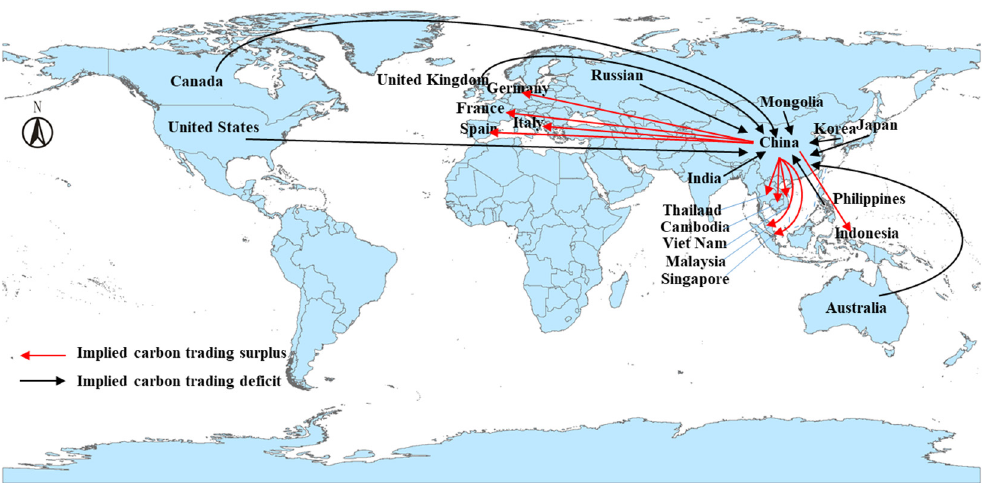
Figure 7. Implied carbon trading of international tourism in China (20 main countries are shown).